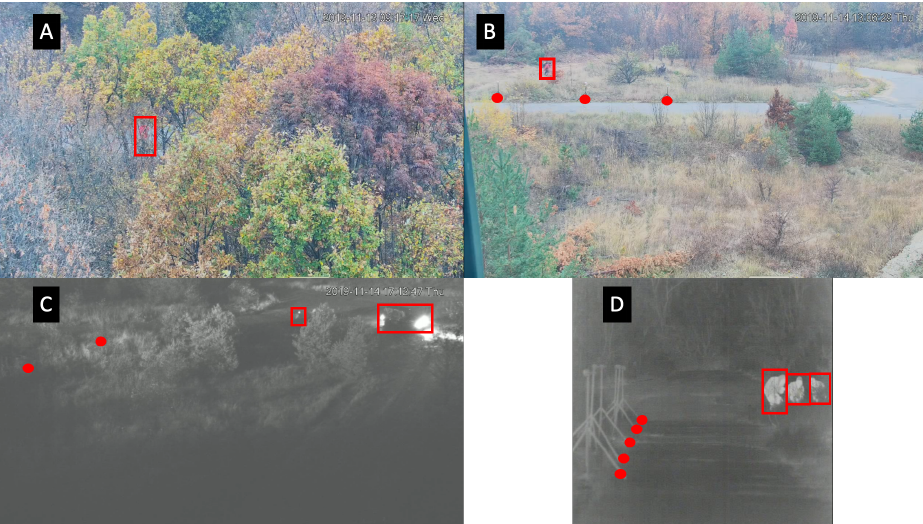
Figure 3. Examples of images contained in the dataset. Detected objects in these images are enclosed in a red bounding box. Deployed PIR sensors are marked with red circles. ( A ) A person is observed through the trees on the RGB camera; ( B ) a person is observed near the road on the RGB camera; ( C ) a person and a vehicle are observed by night on the RGB camera; ( D ) three people are observed hiding through the trees on the thermal camera.